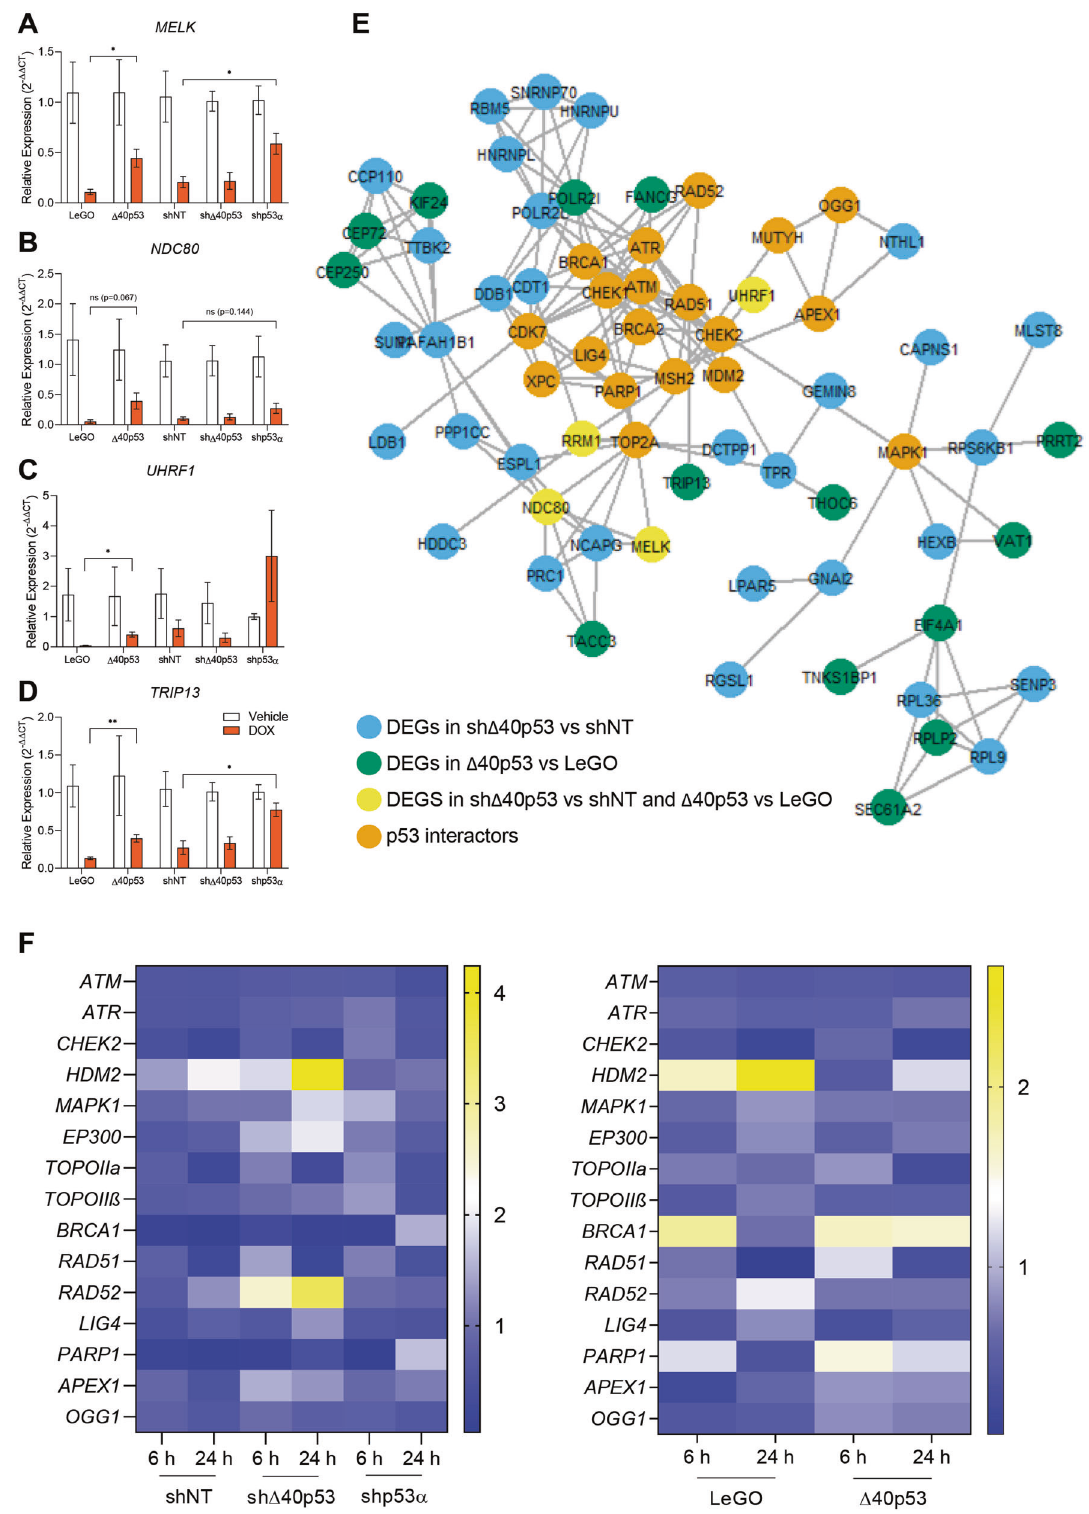
proportion of Annexin-V positive cells at each time point relative to the proportion at 0 h. For ZR75-1 cells, the Trypan blue exclusion assay and Promega RealTime-Glo ™ Annexin V Apoptosis assays were used. For Trypan blue, cells were counted after treatment using the automated cell counter Countess II (Life Technologies). Data are shown as the percentage of viable cells for each time point relative to vehicle-treated cells. For